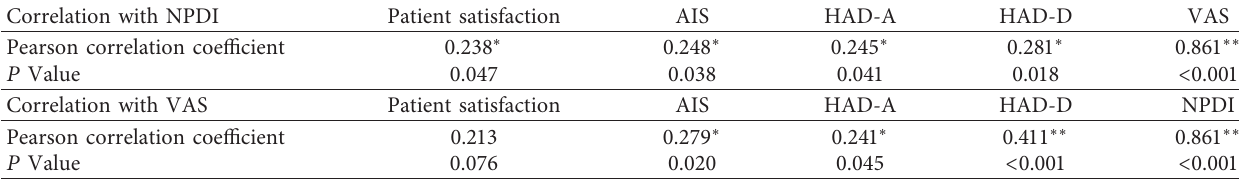
Table 5: Correlations between NPDI, VAS score, and other outcome